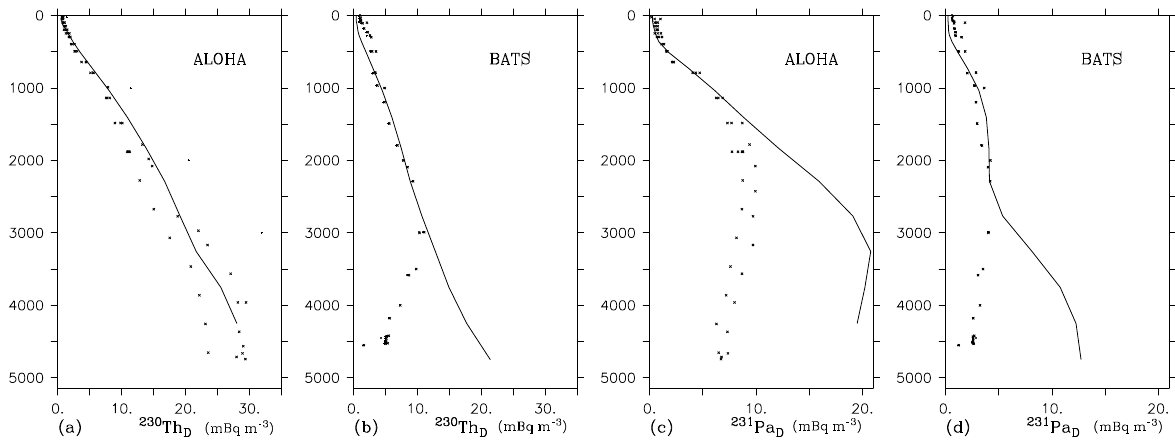
Figure 9. Radionuclide concentrations in mBqm − 3 at stations in the North Pacific (around the ALOHA station, 158 ◦ W, 23 ◦ N) and North Atlantic Ocean (around the BATS station, 64 ◦ W, 29 ◦ N). The left two panels (a, b) display [ 230 Th ] D , and the right two (c, d) [ 231 Pa ] D . The line is the model, and the speckles are the observations.